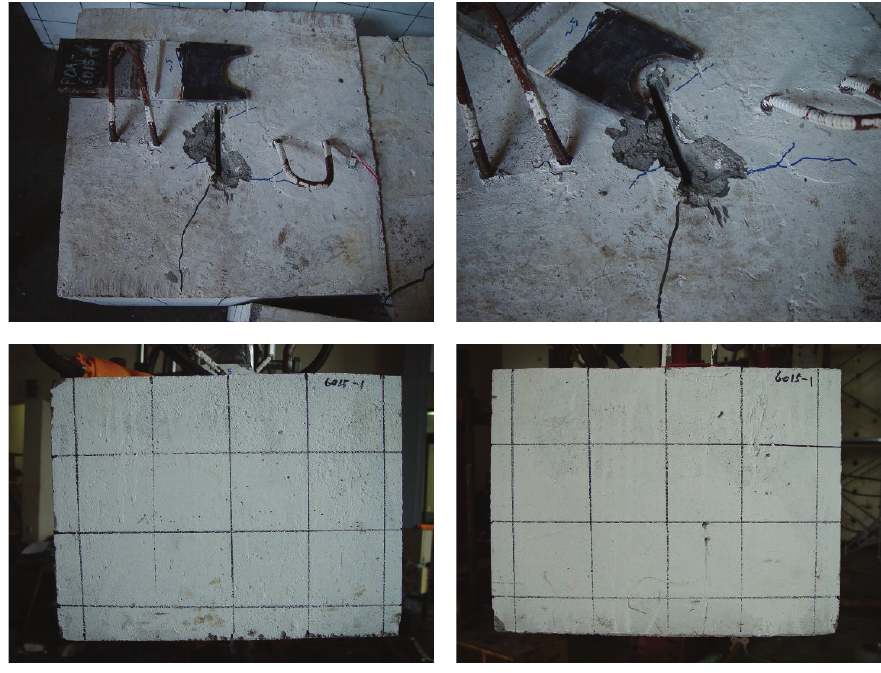
Figure 10: Failure mode of specimen PO-6015-R (Type